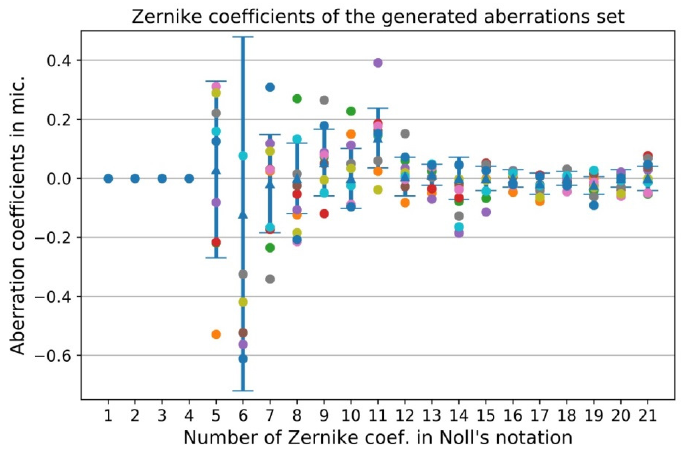
Figure A1. Generating sets of Zernike coefficients. Each of the ten sets is marked with different-colored circle markers. The blue vertical lines mark the variance value of the corresponding Zernike coefficient. The x -axis shows the numbers of the coefficients in Noll’s notation; the y -axis shows the values of the coefficients in micrometers.